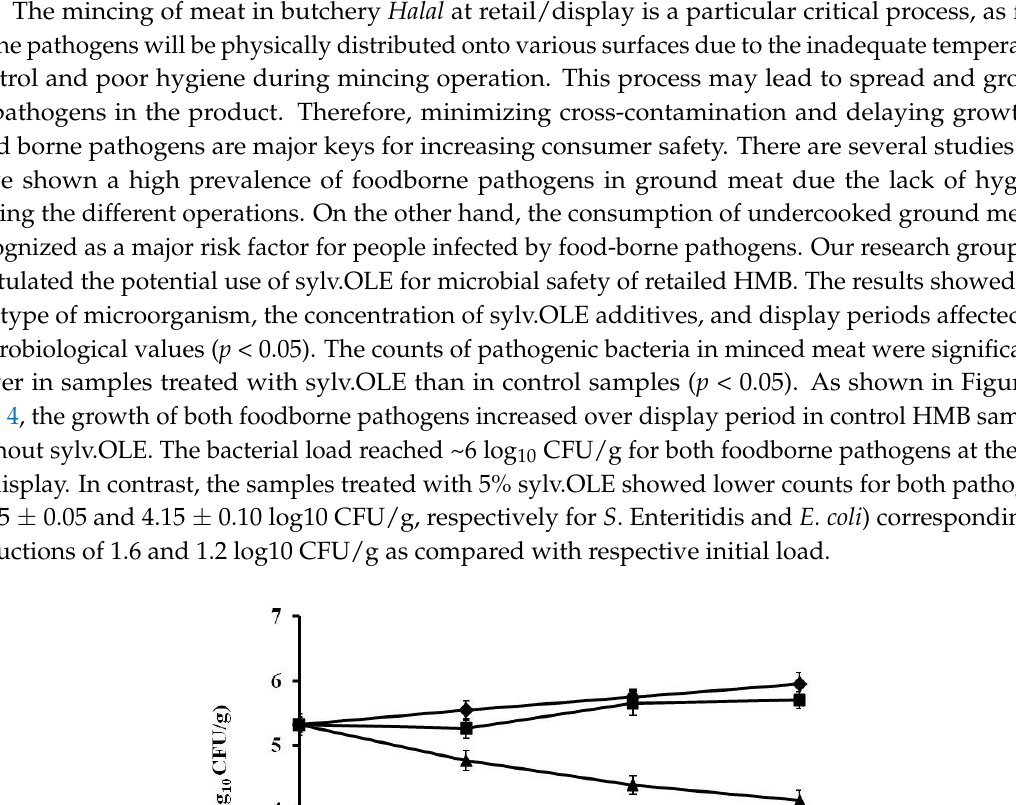
Figure 4. Salmonella enterica ser. Enteritidis growth rate in HMB during display in the presence of different sylv . OLE concentrations. Antibacterial activity of OLE was also tested using agar dilutions and broth microdilution techniques, and was found to be very active against a wide range of microorganisms, with minimum inhibitory concentrations (MICs) as low as 0.31–0.78% (v/v) [50]. On the contrary, Albertos et al. [51] found antibacterial activity of OLE against Listeria monocytogenes ( L . monocytogenes ) in agar diffusion